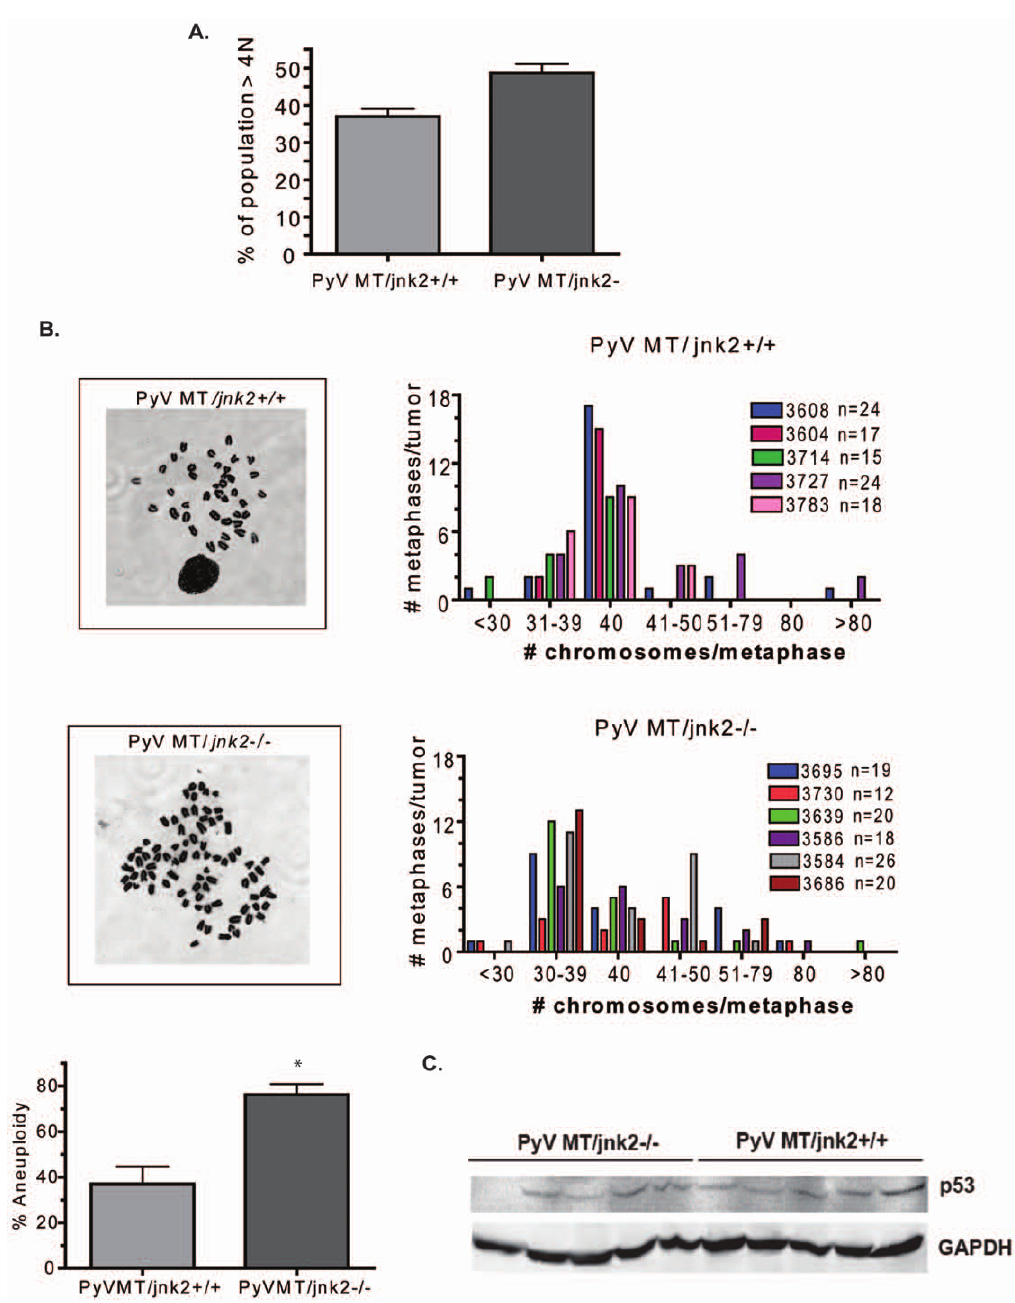
Figure 2. Target tumors obtained from PyV MT/ jnk2 2 / 2 had increased aneuploidy. A ). Tumors were finely minced and digested as described in the Methods section. Cells were trypsinized at passage 2 to 3 and assessed for DNA content using PI staining. PyV MT /jnk2 2 / 2 tumors contained more cells with DNA content $ 4N (PyV MT/ jnk2 + / + (n=5), PyV MT/ jnk2 2 / 2 (n=10), p=0.0485); B ). Primary cells were treated with colcemid and harvested to assess number of chromosomes per metaphase. The number and frequency of abnormal (aneuploid) chromosome numbers are higher in PyV MT /jnk2 2 / 2 compared to PyV MT/ jnk2 + / + (p=0.0043). Each colored bar represents a single target tumor obtained for an individual mouse. The number to the right of the mouse number denotes the number of metaphases counted for each target tumor. The graph illustrates the frequency of a particular chromosome number for each target tumor; C ). Tumor lysates were subjected to SDS PAGE and western blotting using p53 primary antibody and detected using chemiluminescence. GAPDH primary antibody was used to assess similar loading amongst samples. cycle progression. This latter response is mediated by various phosphatases which act upon proteins including pH2AX, see ref [19] for review. JNKs were recently shown to directly phosphorylate H2AX on Ser139 [21]. Therefore, we hypothesized that pH2AX would be reduced in jnk2 knockout tumors.